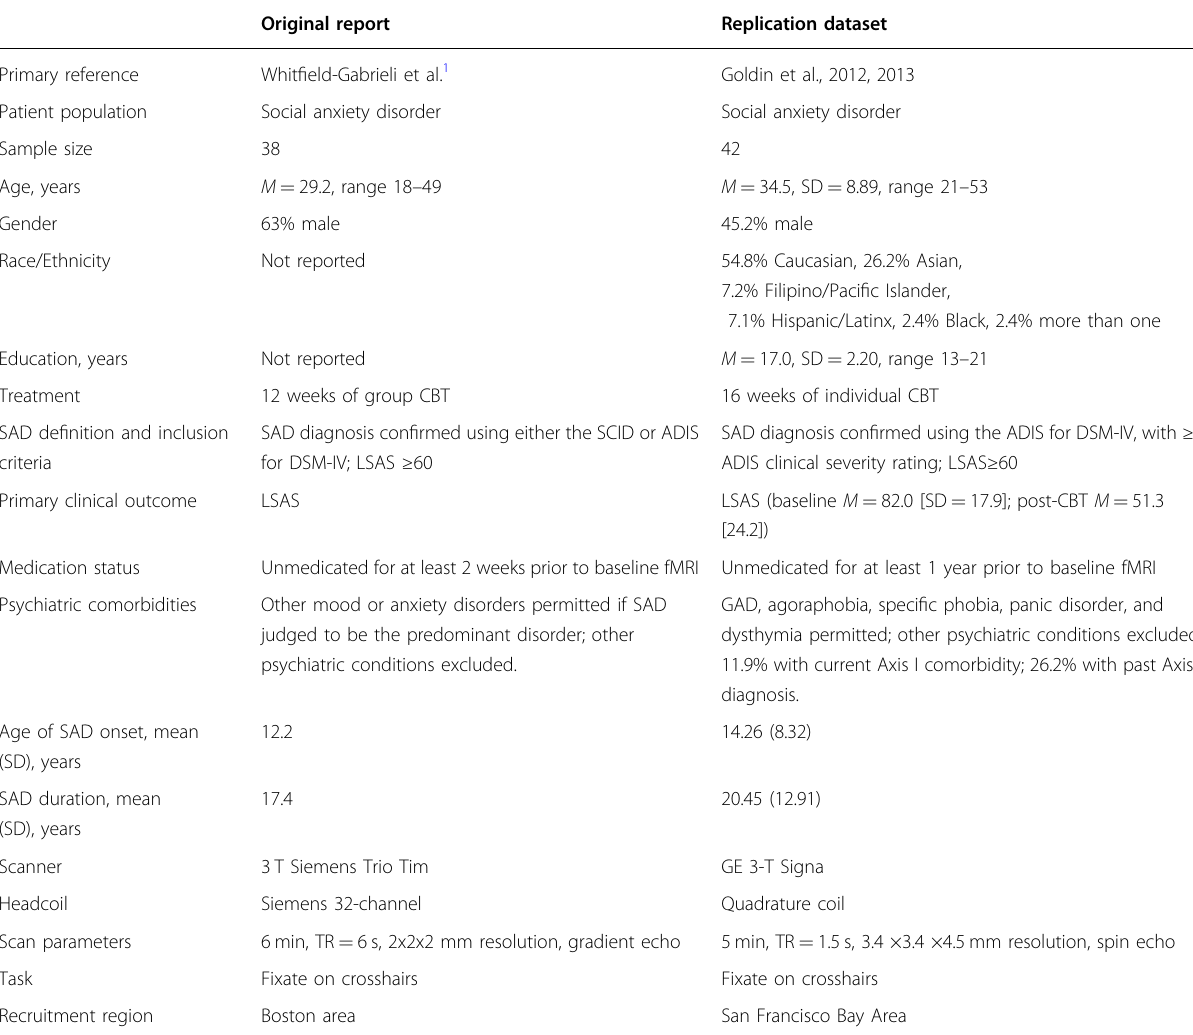
Table 1 Comparison of original and replication